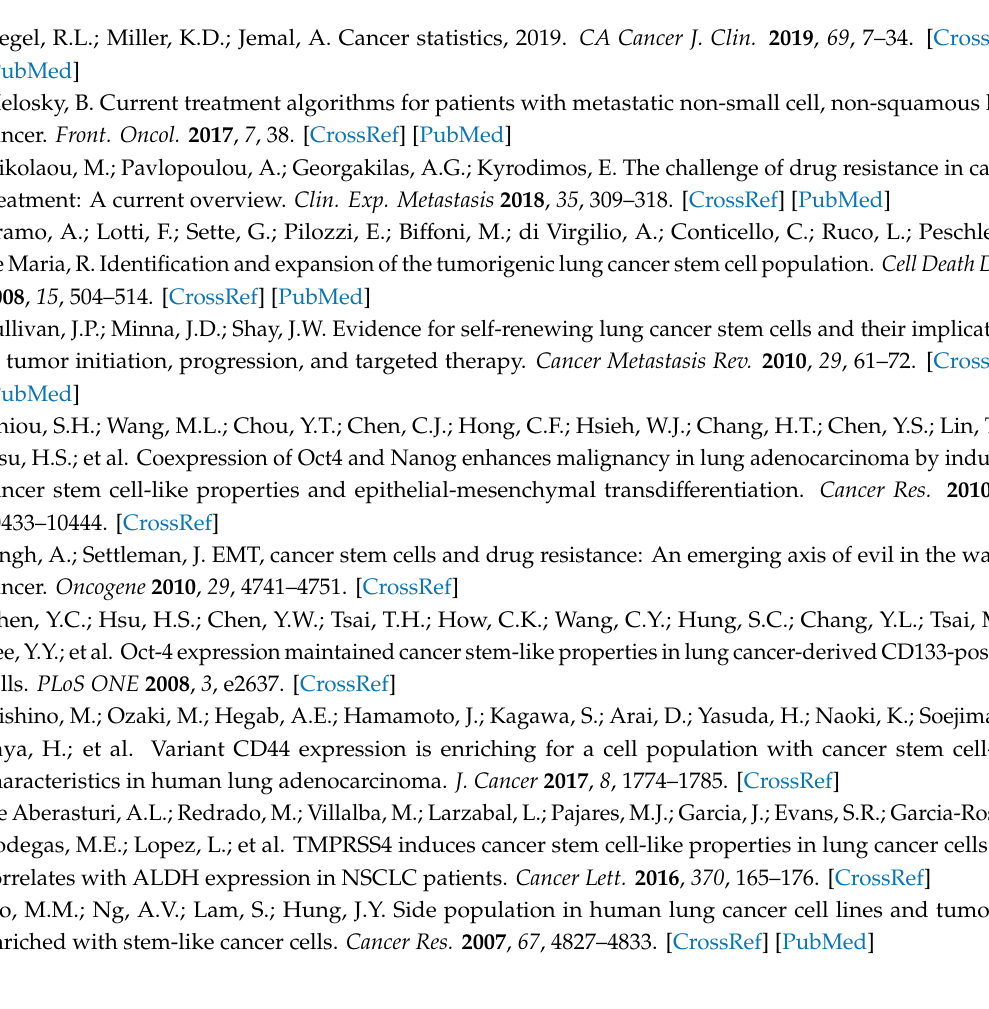
Figure S1: Correlation of USPs and Oct4 / Sox2 expression in lung adenocarcinoma; Figure S2: USP4 significantly regulates proteins expression of Oct4 and Sox2; Figure S3: Silencing of USP4 downregulates Twist1, Oct4 and Sox2 expression and inhibits stemness of lung cancer A549 cells; Figure S4: Ectopic expression of USP4 upregulates Twist1, Oct4 and Sox2 expression and promotes stemness of lung cancer A549 cells; Figure S5: Ectopic expression of USP4 increases Oct4 and Sox2 protein levels via upregulation of Twist1 protein expression; Figure S6: Genes related to TNF and Notch signaling used for Gene signature enrichment